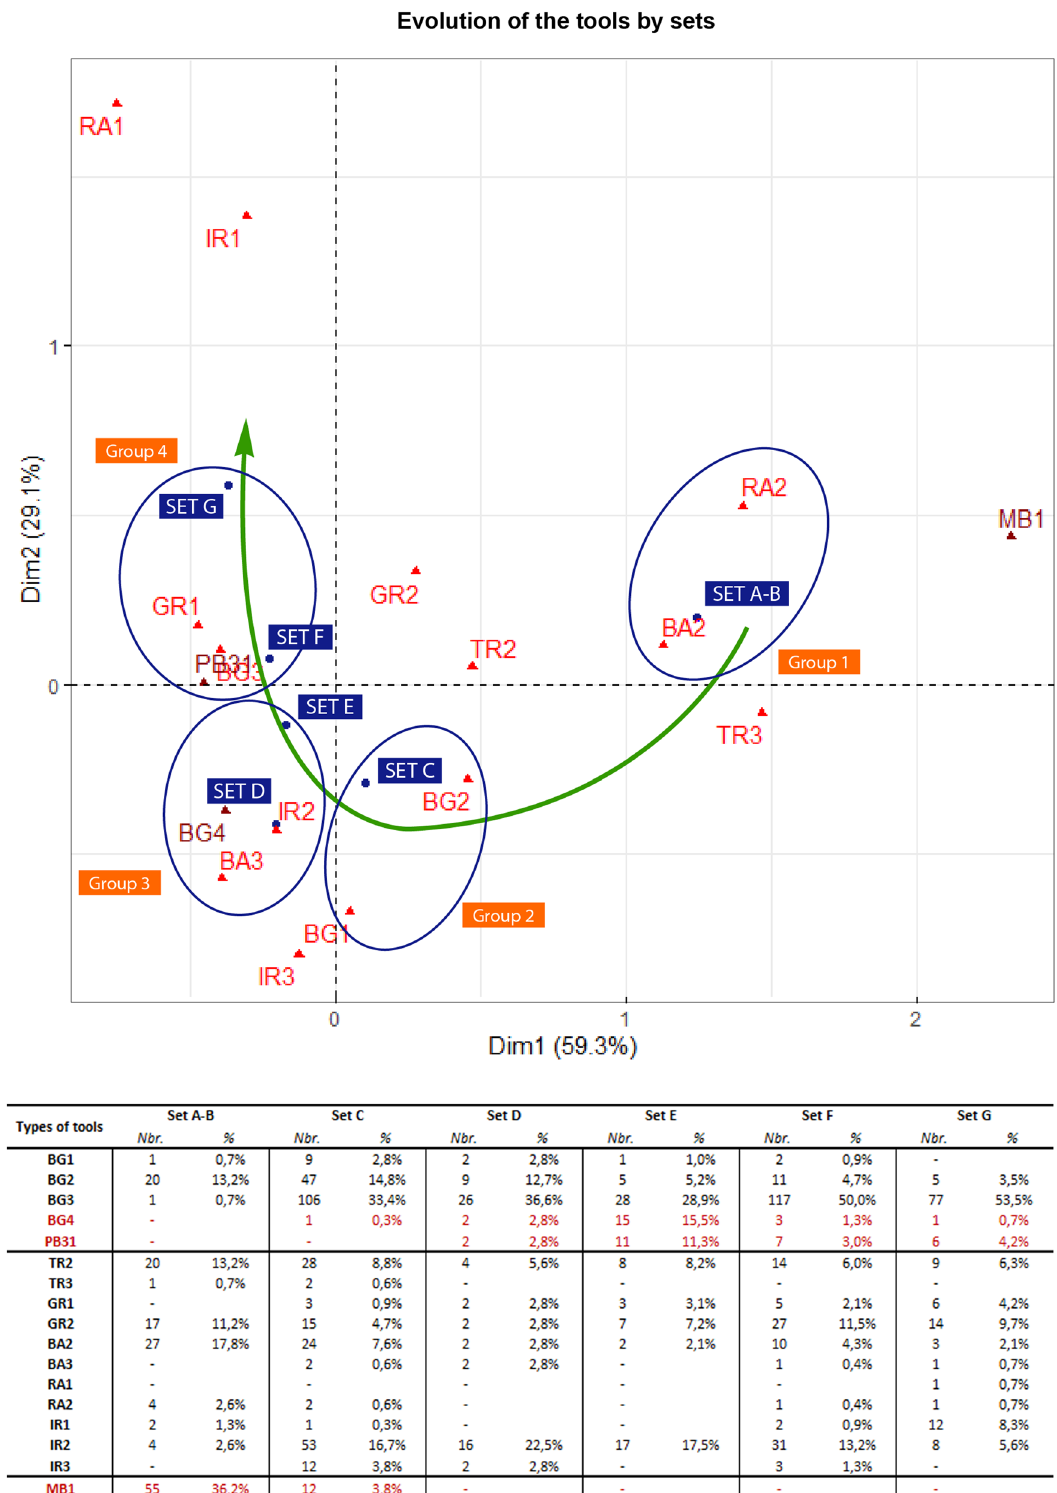
Figure 10: FCA based on the percentages of the main lithic tool classes by archaeological sets. The dots correspond to the archaeological sets and the triangles to the di ff erent types of tools. The dark triangles correspond to the supplementary